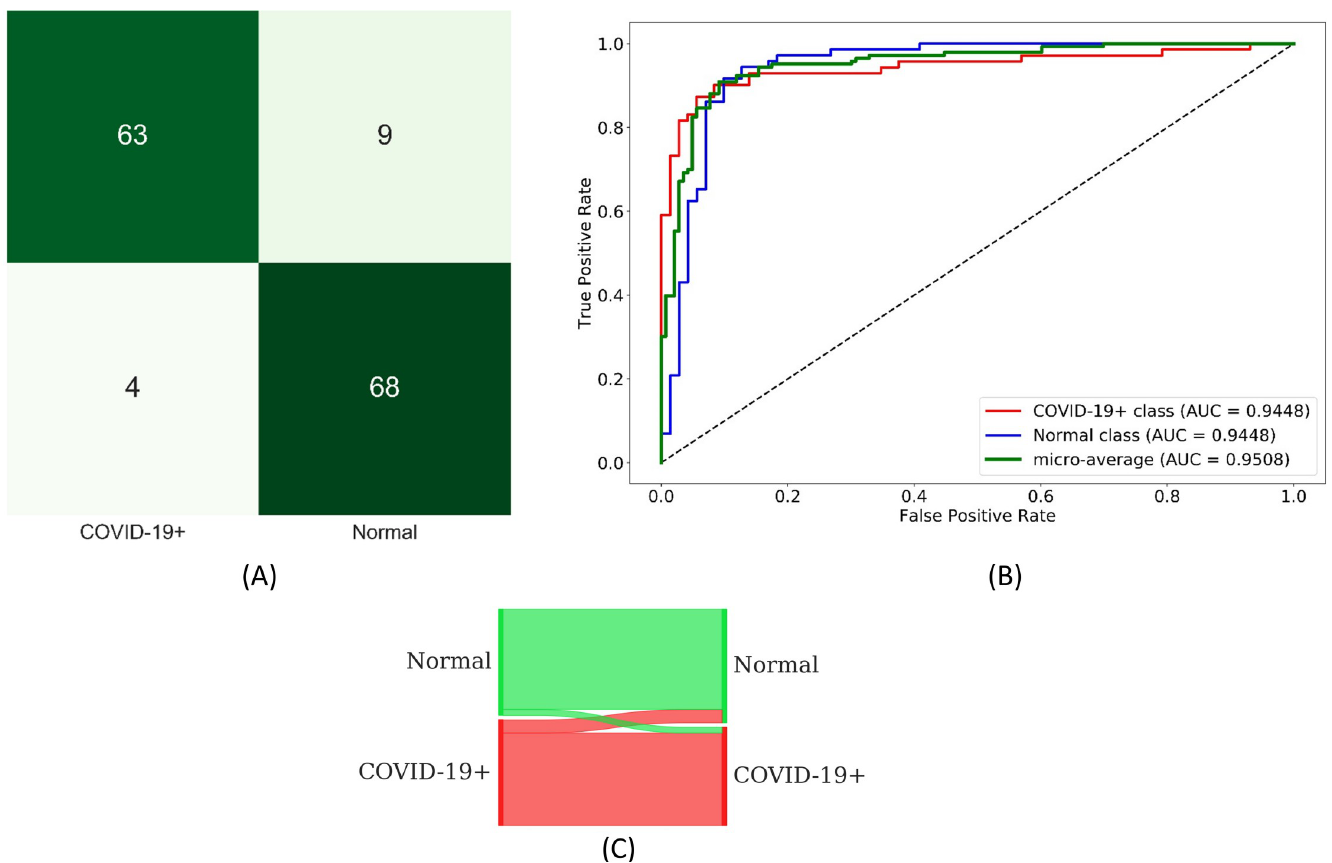
Fig 13. Performance achieved through weighted averaging of the top-3 fine-tuned CNNs toward COVID-19 detection. (A) Confusion matrix; (B) ROC curves; (C) Normalized Sankey flow diagram. https://doi.org/10.1371/journal.pone.0242301.g013 baseline CNNs like ResNet-18, Inception-V3, and MobileNet-V2, which possibly suffered from baseline overfitting that resulted in poor learning and generalization.